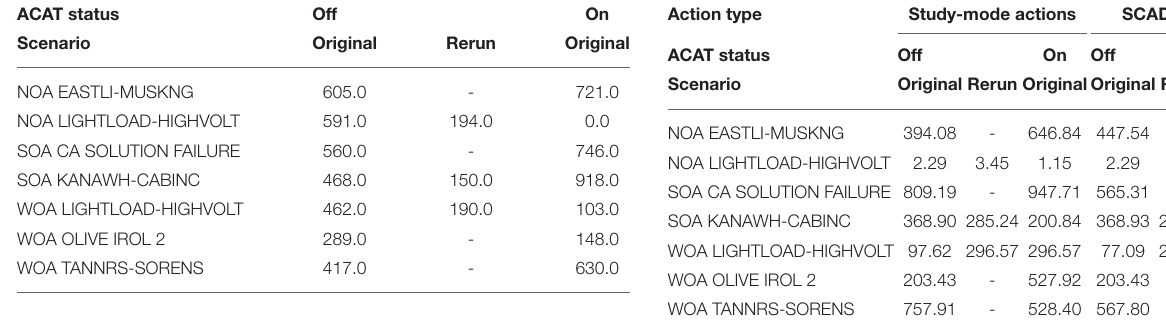
TABLE 6 | Action penalties for each